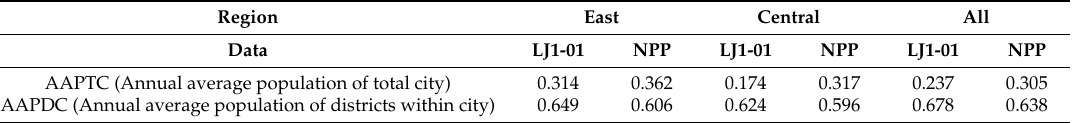
Table 4. Linear regression R 2 values for population and TNL.